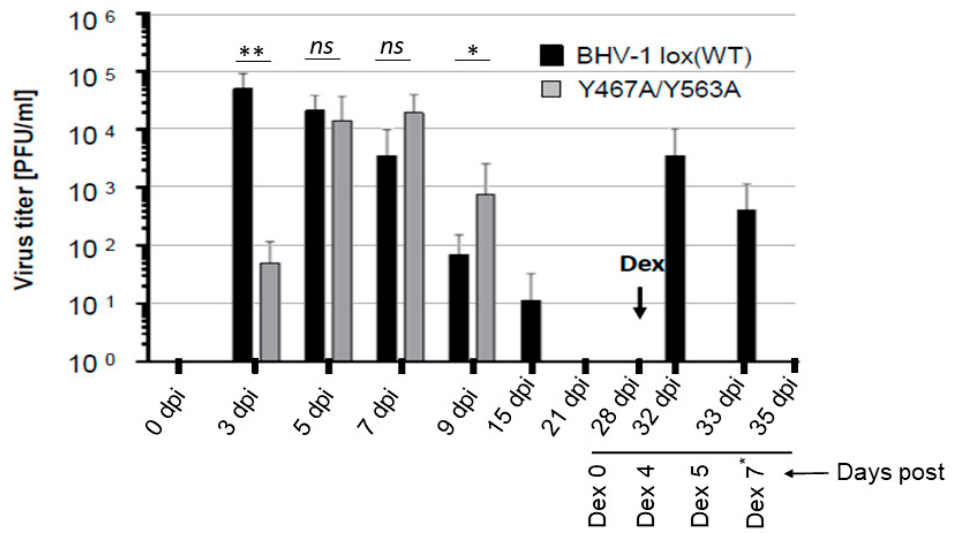
Figure 3. Nasal virus shedding of BHV-1 lox (wt) or BHV-1 Y467A / Y563A in infected rabbits. Quantification of BHV-1 wt and BHV-1 Y467A / Y563A viruses present in nasal swabs of rabbits during the primary infection, latency, and dexamethasone-induced latency reactivation. The viruses were isolated at the indicated time points and titrated by plaque assay on MDBK cells. The data represent averages and standard deviations for each group. Dex refers to the onset of dexamethasone injection. The p -values are indicated as * p < 0.05, ** p < 0.01. and nonsignificant ( ns ) for p > 0.05. Note that on Dex 7* day, nasal swabs were collected only from the rabbits infected with Y467A / Y563A double mutant